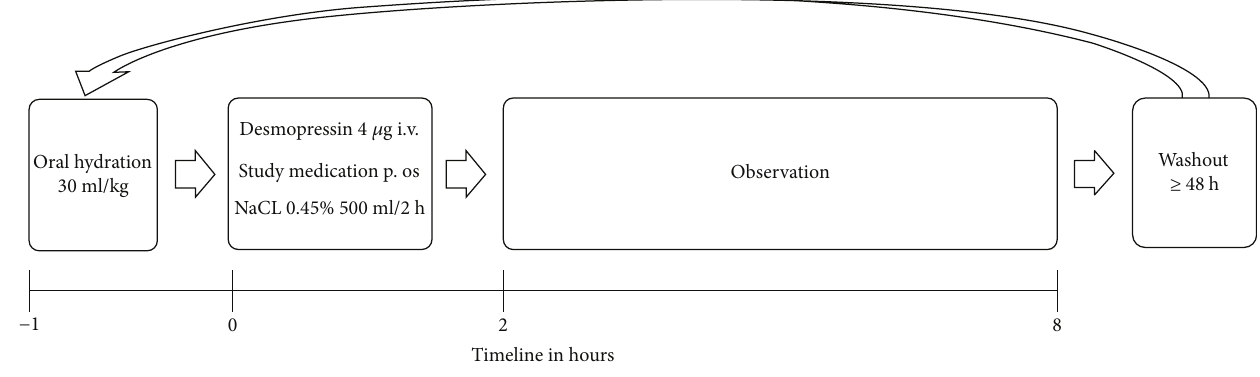
Figure 1: Schematic fi gure of the study procedure; h